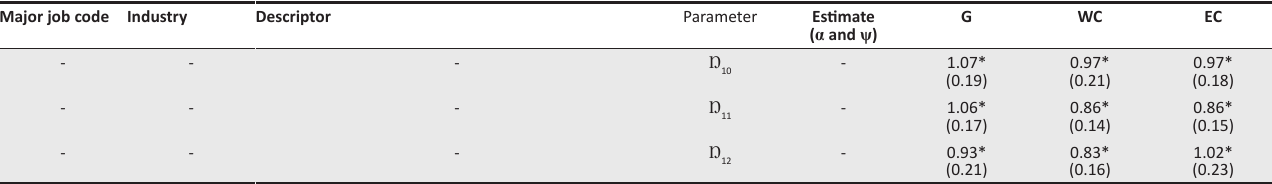
TABLE 3 (Continues...): Capital efficiency, firm-based characteristics and estimates of the marginal productivity model for the construction industries. Major job code